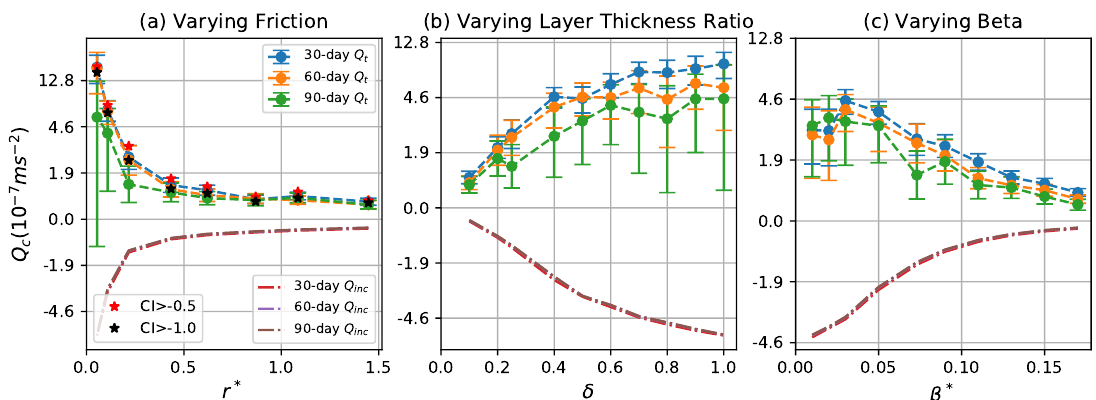
Figure 11. Net meridional PV flux (per coherent particle) due to coherent eddies as a function of ( a ) r ∗ , ( b ) δ , and ( c ) β ∗ . Blue, orange, and green curves correspond to the mean of the net PV flux for 30-, 60-, and 90-day eddies, respectively. Error bars give two times the standard error of the mean over 100 time intervals. The dash-dot red, purple, and grey lines indicate the averaged incoherent meridional PV flux over the 100 30-, 60-, and 90-day intervals, respectively. Red and black stars in the left panel indicate the mean PV flux for 30-day eddies detected by varying the CI threshold to − 0.5 and − 1.0,